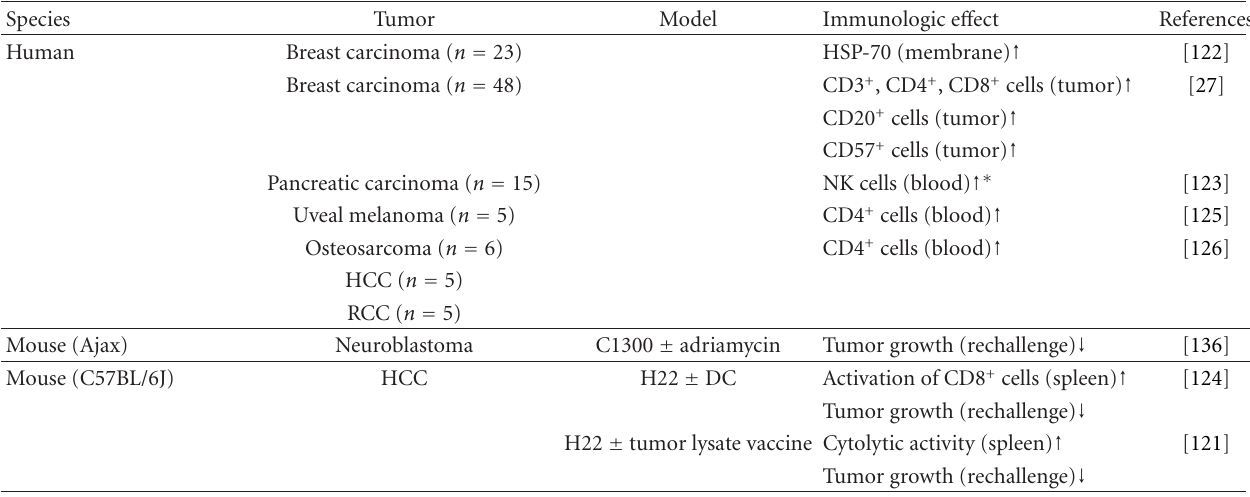
Table 5: Studies reporting immune modulation in cancer patients and animal models treated with HIFU.